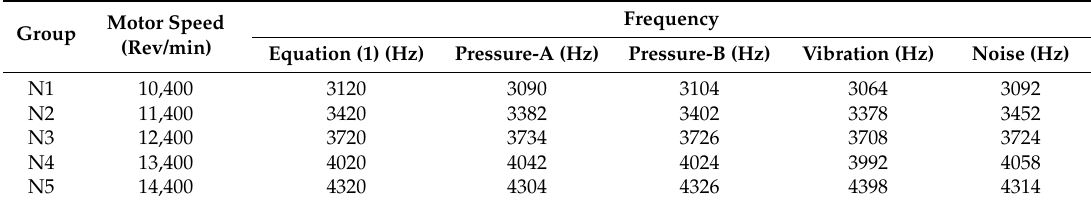
Table 5. Comparison of the calculated and experimental primary frequencies for the Type A flapper-armature